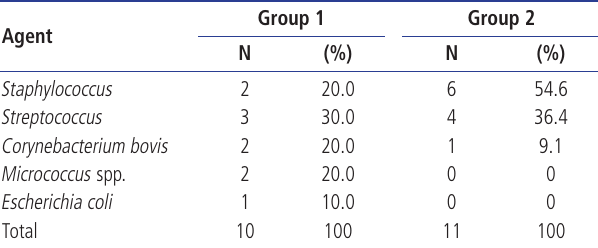
Table 3. Number of microorganisms isolated from Murrah buffalo milk at different stages of lactation